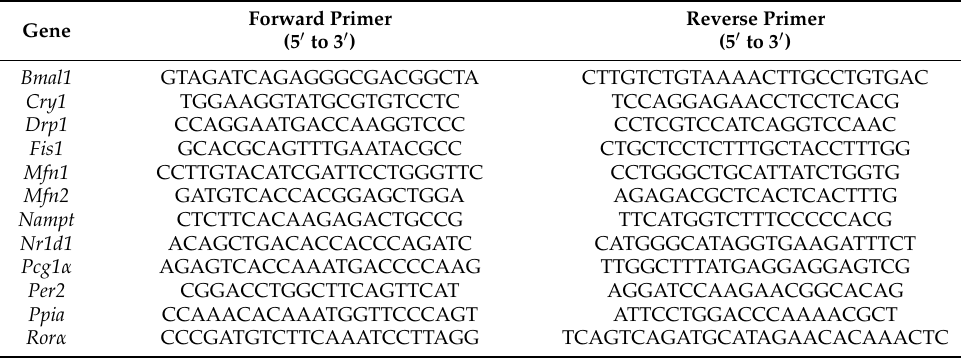
Table 1. Nucleotide sequences of primers used for real-time quantitative